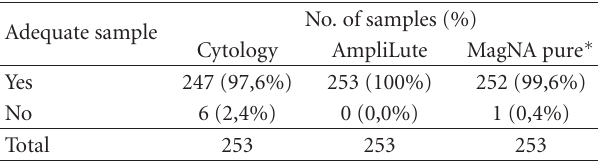
∗ DNA-I modified protocol using 1mL PreservCyt sample.